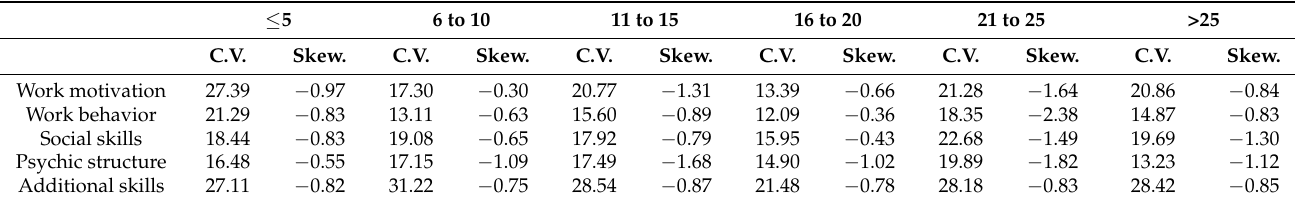
Table 16. Coefficients of variation (C.V., measured in percent) and skewness (Skew.) of the overall answers of the different scales of the questionnaire when the sample is differentiated by years of teaching experience. ≤ 5 6 to